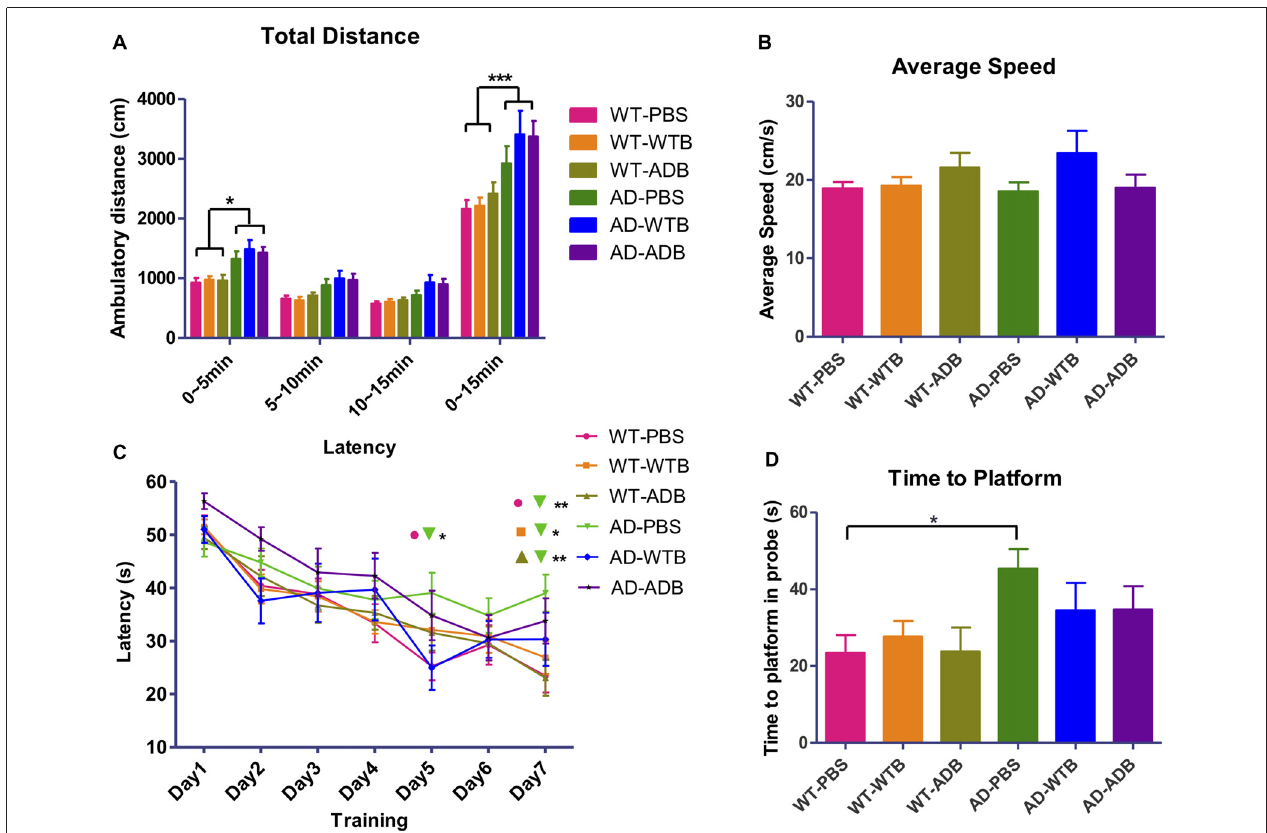
FIGURE 8 | Feeding brain extracts at the age of 6 months did not alter the behaviors of mice. (A) The diagram summarizing the total ambulatory distance (cm) for each of the six groups ( n = 9–22 per group) in the open-field test for the three 5 min blocks in 15 min observation. (B) The diagram representing the average swimming speed for different groups ( n = 14–25) in Morris Water Maze test. (C) The average escape latency (four trails per day) for seven consecutive days and (D) Time for reaching the former platform location at the first time in the probe test. Diagrams in (A,C) were analyzed with two-way ANOVA, Tukey’s multiple comparisons post hoc . Diagrams in (B,D) were analyzed with One-way ANOVA, Tukey’s multiple comparisons post hoc . Significance level between certain groups are indicated with brackets ( ∗ P < 0.05, ∗∗ P < 0.01, ∗∗∗ P <